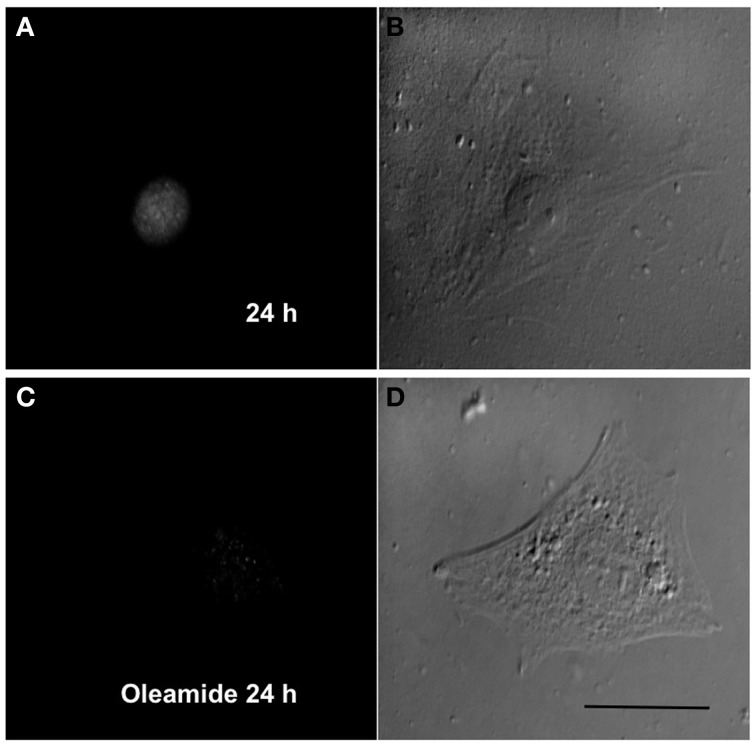
Panx1 channels, but not gap junction channels, are needed for myogenic commitment acquisition of RCs. Sparse reserve cells (RCs), to avoid gap junction formation, were cultured under control conditions (A) or in the presence of 100 μM oleamide (C), which is a Panx1 channel blocker. After 24 h of culture, cells were fixed and processed for MyoD detection by immunofluorescence. Panels (B) and (D) are phase contrast views of the fluorescent fields shown in (A) and (C), respectively.